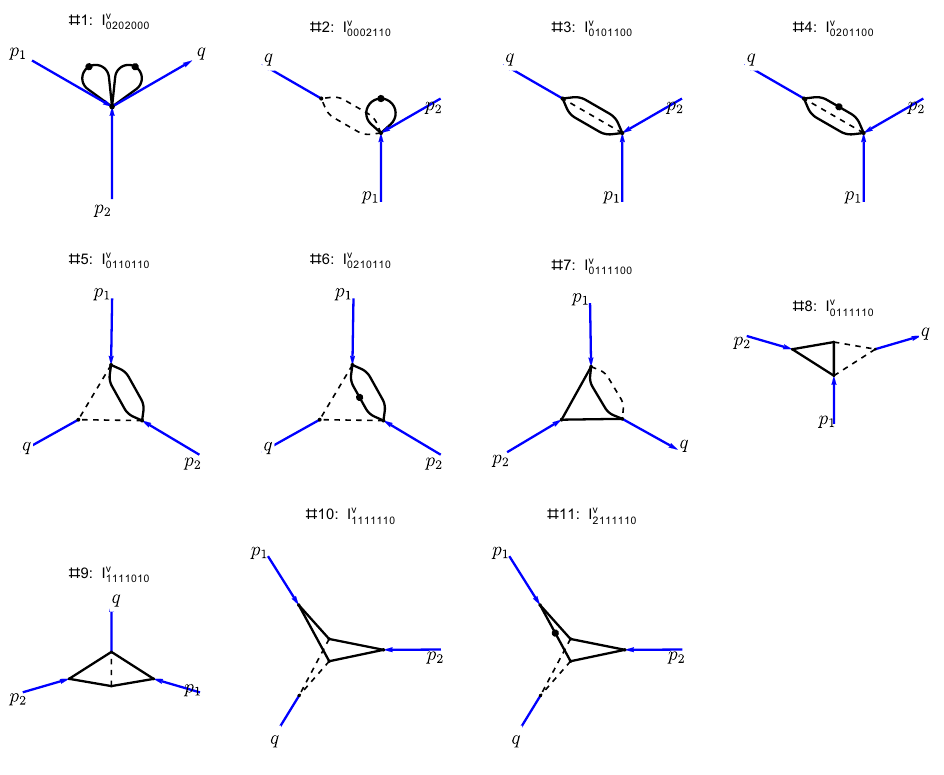
Figure 4 . IBP master integrals for integral family in eq. (2.1). Solid lines stand for massive propagators and dashed for